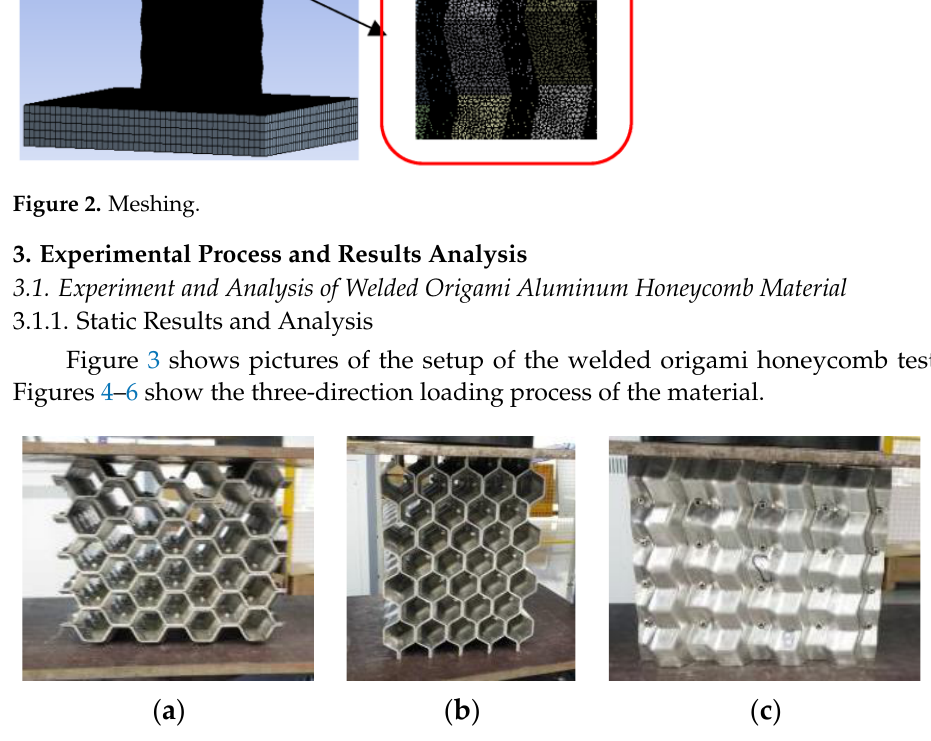
Figure 3. Installation diagram of the welded origami honeycomb test. ( a ) Lateral installation of the test specimen. ( b ) Radial installation of the test specimen. ( c ) Axial installation of the test specimen.